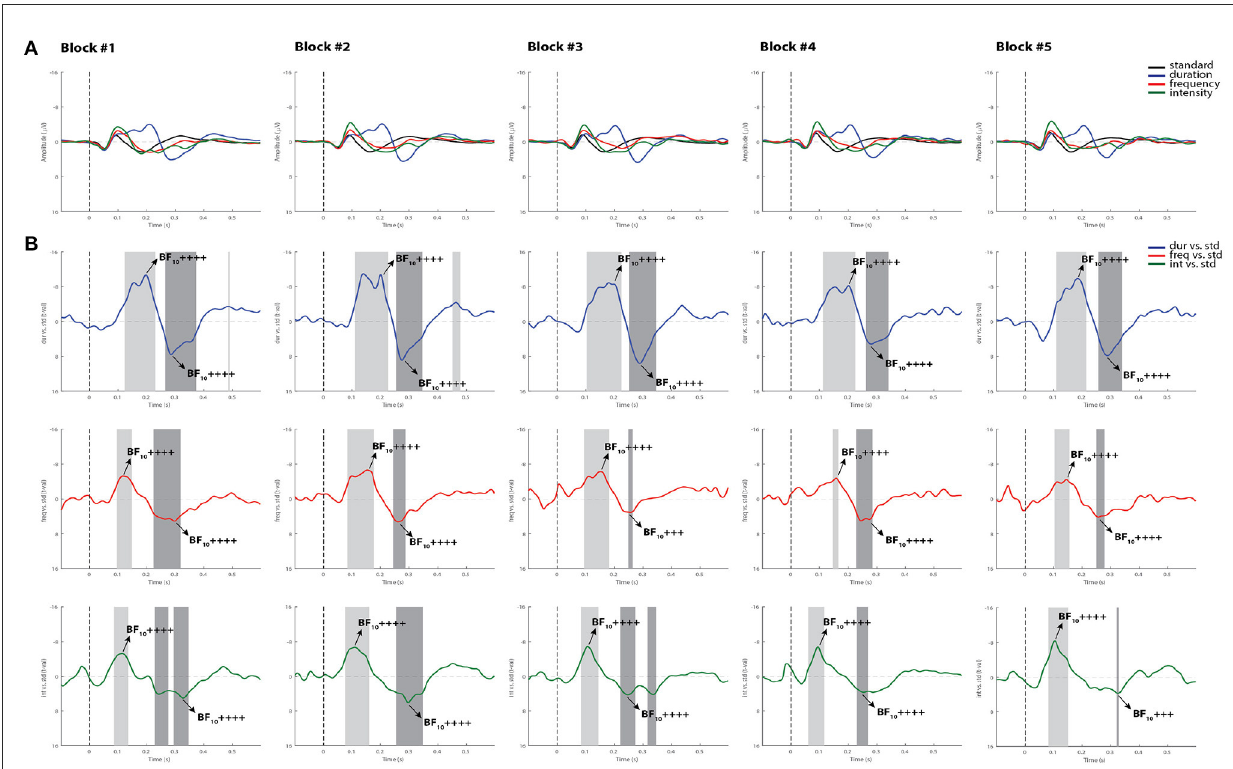
FIGURE2 Grand-average ERPs and statistical findings in healthy controls. (A) Grand-average ERPs across blocks. (B) Time course of the difference between deviants and standard stimuli expressed in units of t -values. Significant intervals for negative components are denoted by a light gray area, and positive components are denoted by a dark gray area. Black arrows show the latency of maximum Bayes factors and the strength of evidence for H 1: +, anecdotal; ++, moderate; +++, strong, ++++, very strong to extreme.